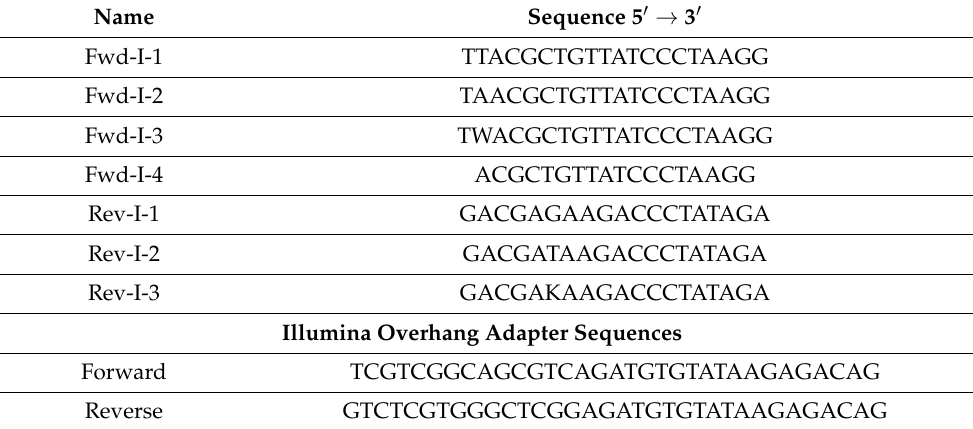
Table 2. Primer sequences tested in this